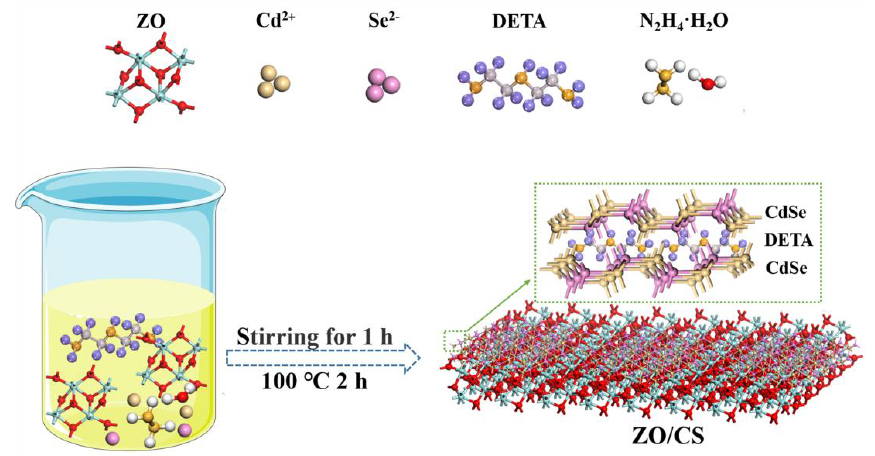
Scheme 1. Schematic diagram for the synthesis of ZO/CS